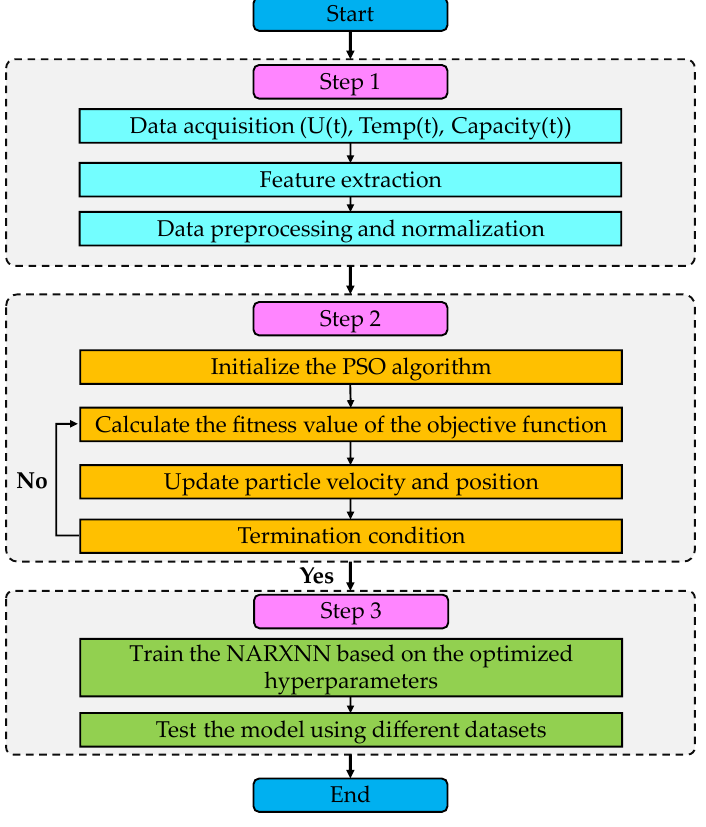
Figure 9. Flowchart of the PSO-NARXNN.